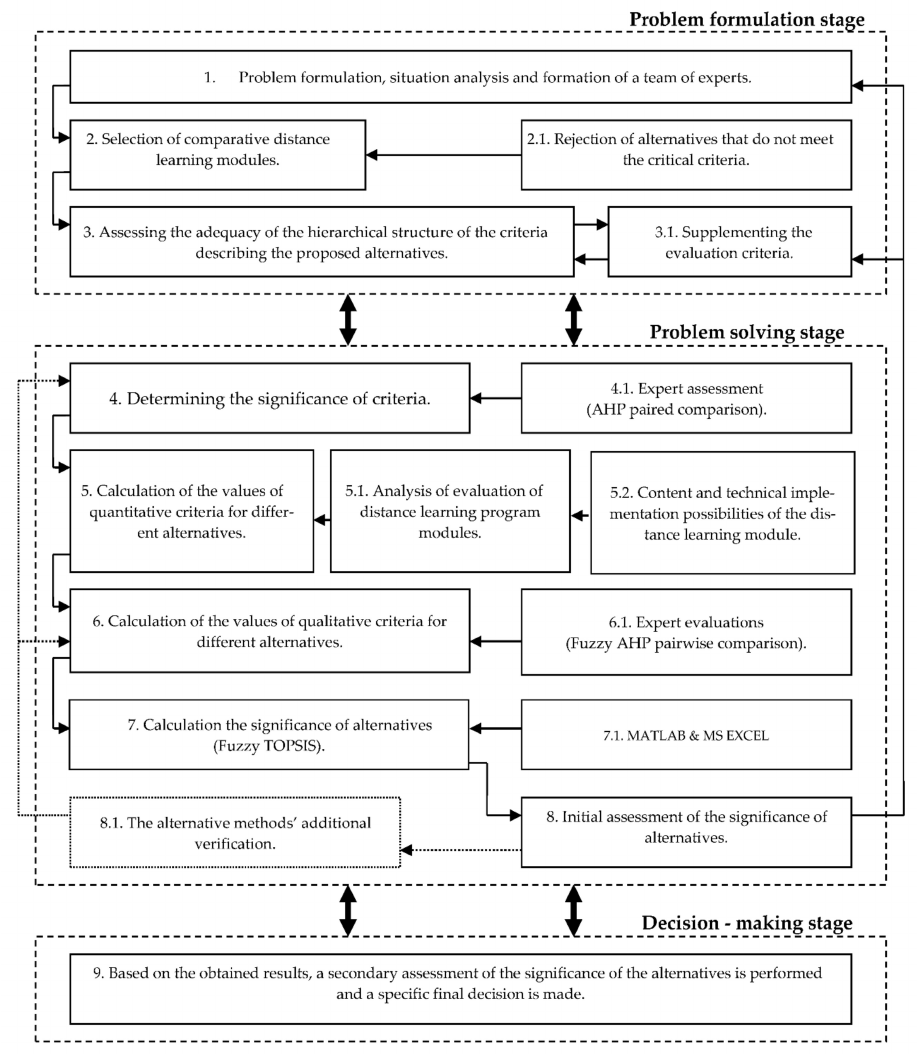
Figure 1. Scheme of distance learning program modules assessing